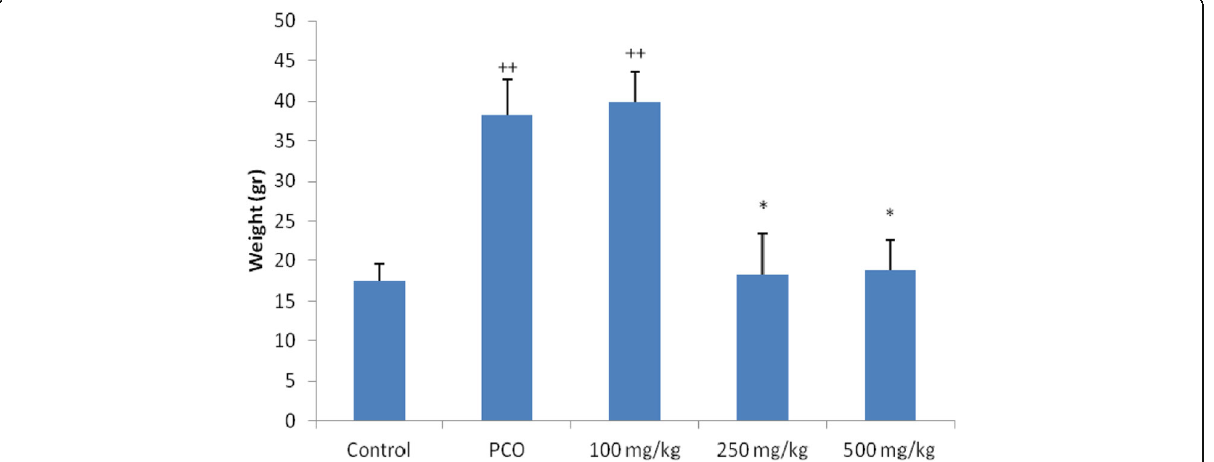
Fig. 1 Weight difference of animals before and after treatment in the groups (mean ± SEM). ++ P < 0.01 PCO and 100 mg/kg of extract versus control, * P < 0.05, extract versus PCO